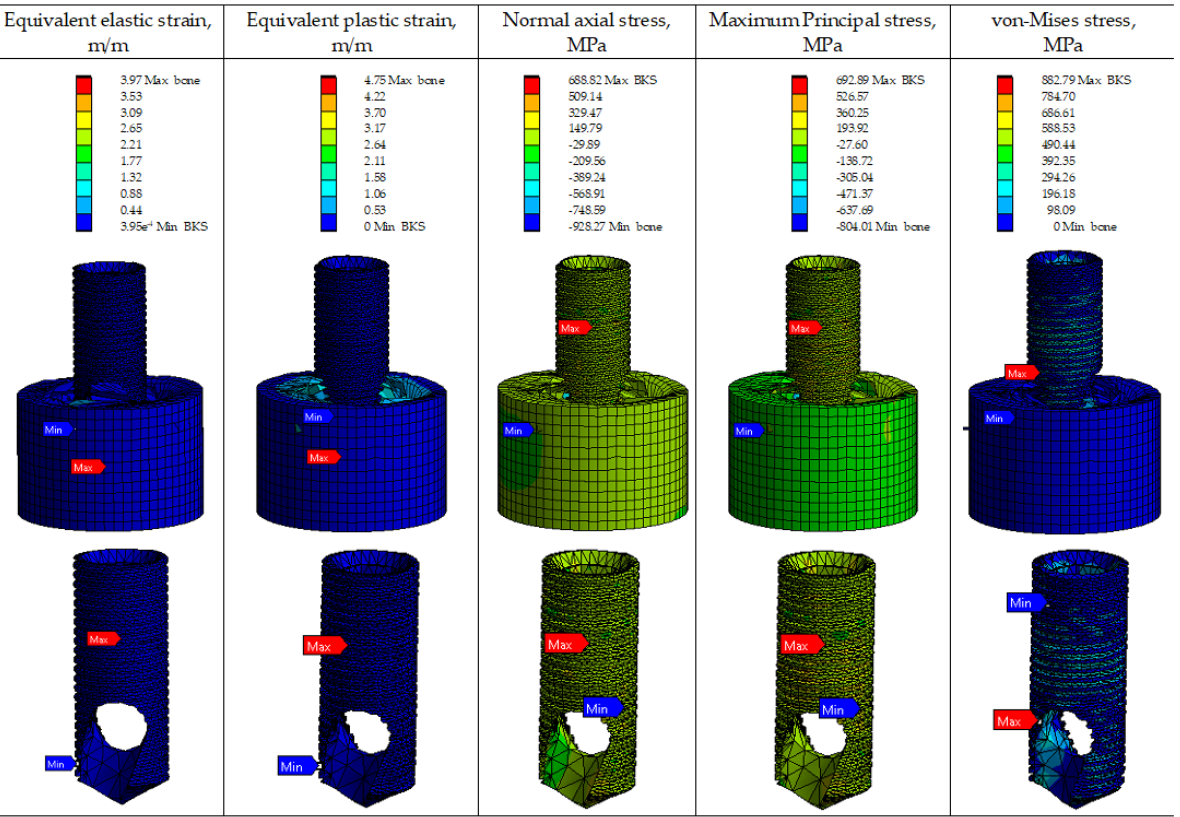
Figure 3. Numerical results at the end time of the simulation.